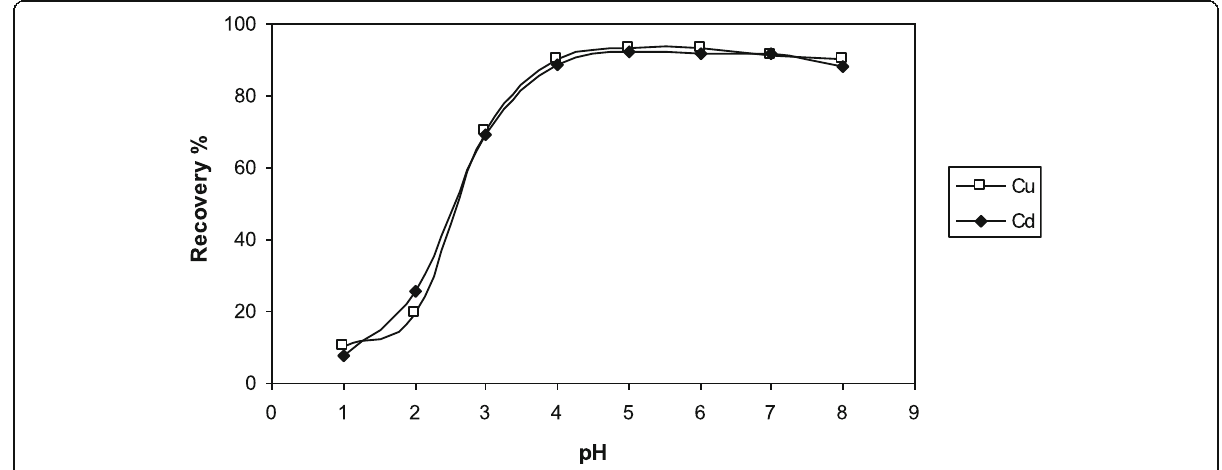
Fig. 1 Effect of pH on the recovery of Cu(II) and Cd(II) by Phanerochaete chrysosporium immobilized on bentonite